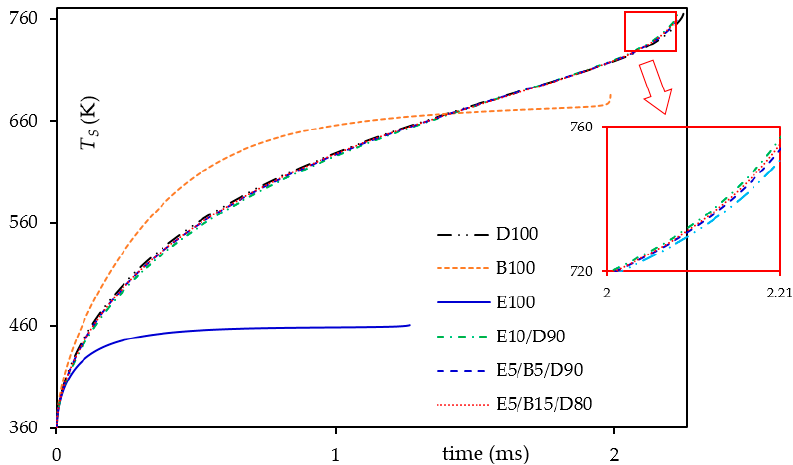
Figure 1. The evolution of droplet radii for pure diesel (indicated as D100), pure biodiesel (indicated